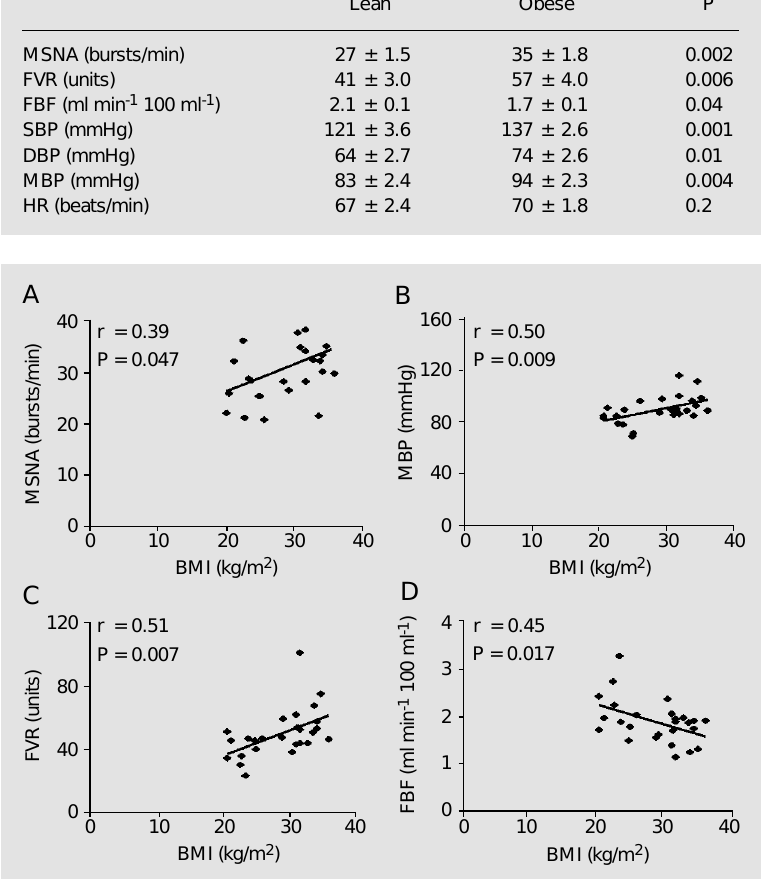
Figure 1 - Correlation between body mass index (BMI) and muscle sympathetic nerve activity (MSNA, panel A), mean blood pressure (MBP, panel B), forearm vascular resistance (FVR, panel C), and forearm blood flow (FBF, panel D) in middle-aged obese women. The Pearson correlation coefficient was used to evaluate the correlation between